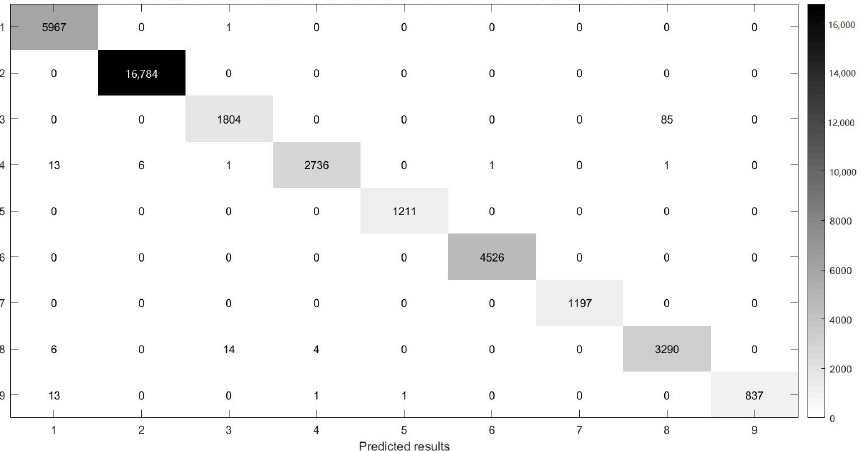
Figure 17. The confusion matrix between the predicted results of MSR-3DCNN and ground truth on the PU dataset using 10% samples for training and ( 9 × 9 ) patch